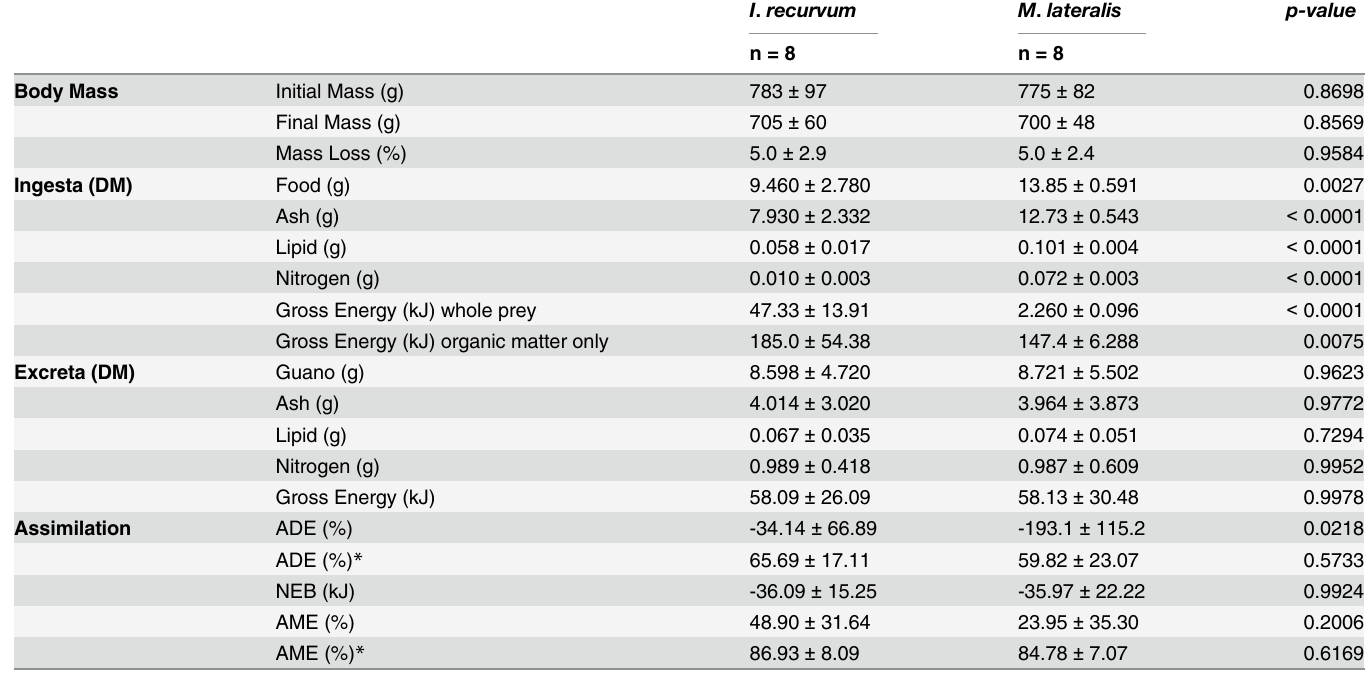
Table 4. Means ( ± 1 SD) of surf scoter body mass before and after trials; of food (dry mass), ash (g DM), lipid (g DM), nitrogen (g DM), and gross en- ergy (kJ) ingested; of guano (dry mass), ash (g DM), lipid (g DM), nitrogen (g DM), and gross energy (kJ) excreted; and of apparent digestible ener- gy (ADE; %kJ), nitrogen energy balance (NEB; kJ), and apparent metabolizable energy (AME; %kJ) determined for surf scoters fed 25 g fresh mass (whole bivalves) of the hooked mussel ( Ischadium recurvum ) and dwarf surfclam ( Mulinia lateralis ), the top two prey items consumed by wintering surf scoters in the Chesapeake